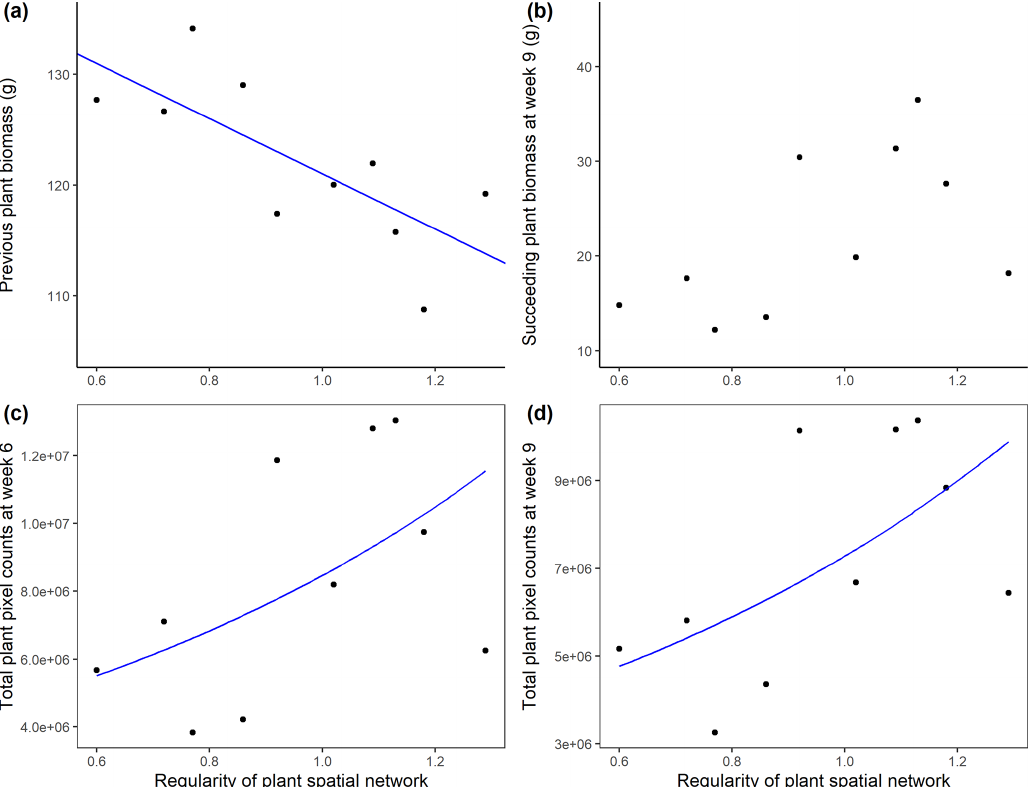
Figure 4. Aboveground biomass (g, dry weight) of initial A. stolonifera plants (a) and aboveground biomass in week 9 (b) , and plant cover (unitless plant pixel count) in week 6 (c) and week 9 (d) of the newly grown L. perenne and P. lanceolata vegetation as a function of the regularity (unitless) of the initial Agrostis stolonifera plants’ spatial configuration.